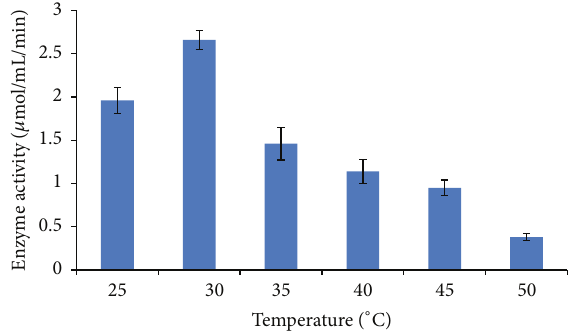
Figure 4: Effect of different levels of incubation temperature on production of L-asparaginase by Streptomyces ginsengisoli . Values are the means of three replicates ± SD.